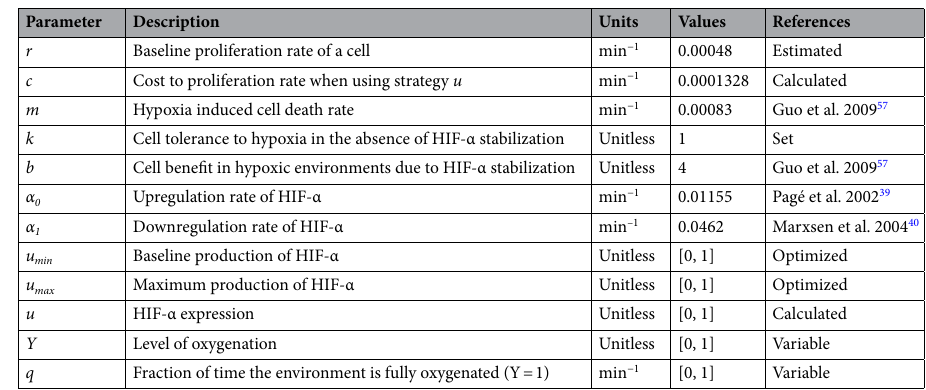
Table 1. Definitions, units, and values of parameters used in the models. The terms Y and u are normalized and are therefore unitless. We normalize k to 1 because it appears as m / k when u = 0 and appears as b / k in u* . The value of c is calculated such that u* = 1 when the environment is hypoxic ( q = 0; c = m /[ b (1 + k/b )] 2 ).